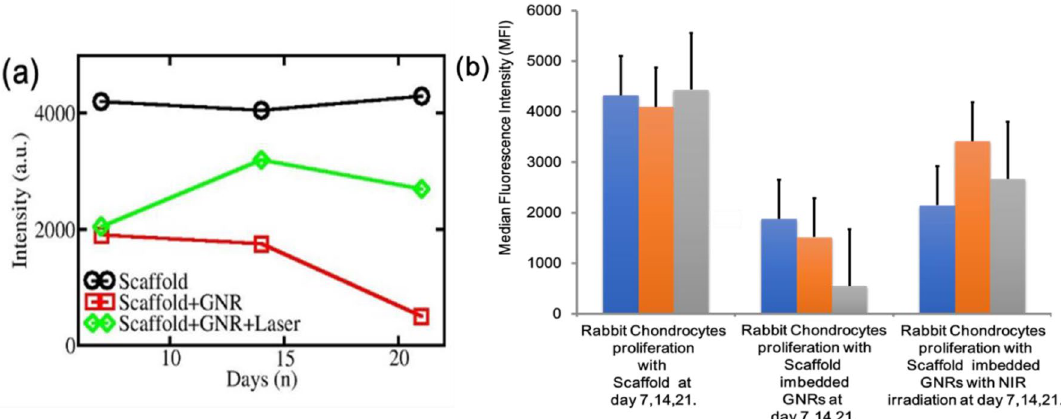
Figure 6. This above figure showed. ( a ) Intensity profile as a function of scaffold, SGNR, and SGNR with NIR irradiation. ( b ) Comparative flow cytometric histogram analysis of rabbit chondrocyte viability by using calcein-AM after 7, 14 and 21 days with specific conditions.